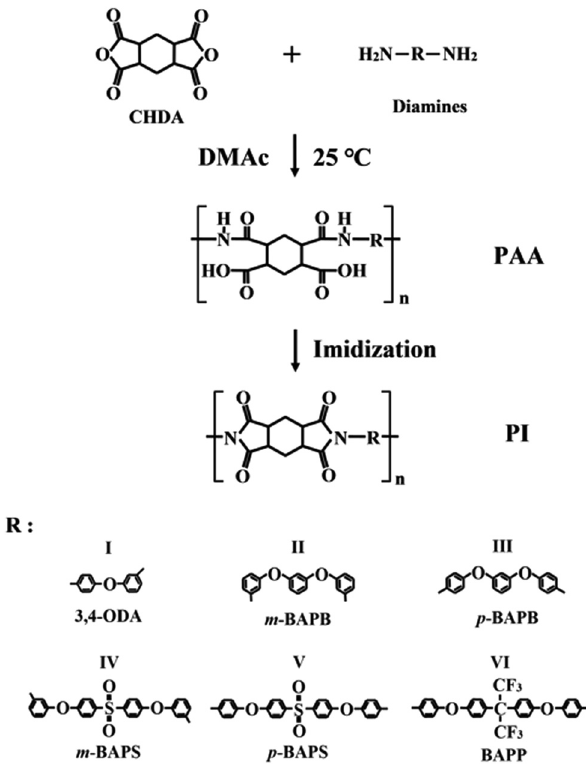
Scheme 1: Synthetic routes for CPI fi lms based on CHDA monomer.